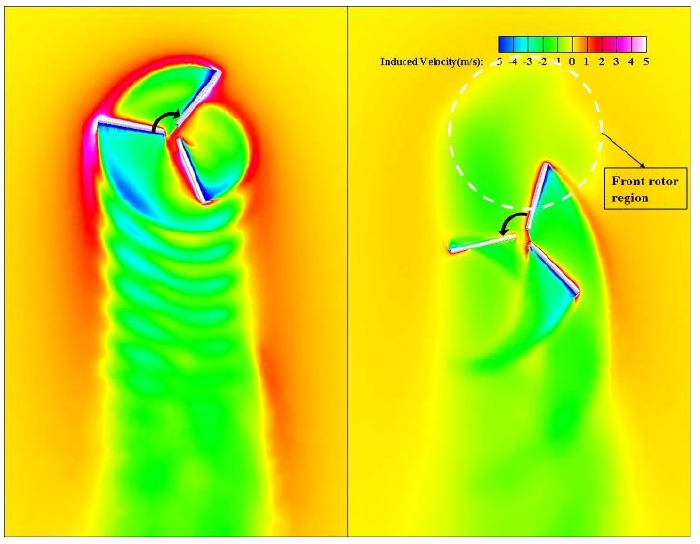
Figure 15. Rotor-induced velocity field at V x = 15 m/s, θ = 10 deg , θ 0 = 3 deg. The interference of the rear rotor is twofold. On one hand, the rear rotor, with a fixed rpm, suffers an evident drop in thrust due to the downwash of the front rotor, which effectively decreases the local aerodynamic AoA, just as the interference occurred on a tandem helicopter such as CH-47. This can be seen clearly on the right side of Figure 15, where the rear rotor is affected by the wake (the green region at the front part of the rear rotor) of the upstream rotor. The other aspect of interference is unique to the problems of autorotation, that is, the steady rotor rpm is further reduced by the upstream rotor wake, which is already seen via the wind tunnel test results. The cause of the reduction in the steady rpm of the rear rotor could be explained by the distribution of the induced velocity of the front rotor shown in Figure 15. One of the conclusions drawn by Figure 9a, that the steady rpm is affected by the shaft angle, needs to be discussed further here. The consequence of the shaft angle increase, from the perspective of the rotor flow field, is an increase in the AoA on the advancing side of the rotor disk and a decrease on the retreating side. Figure 15 shows an opposite scenario, which represents decreasing the shaft angle of the rear rotor. From the left of Figure 15, we can clearly find that the downwash of the front rotor on its advancing side (lower left part of the rotor disk) is larger than that of the retreating side (lower right part). This can also be seen in the right side of Figure 15. This skewed downwash distribution can cause, on the rear rotor, a larger decrease in the AoA on the advancing side than on the retreating side, which in turn causes a decrease in the steady rpm of the downstream